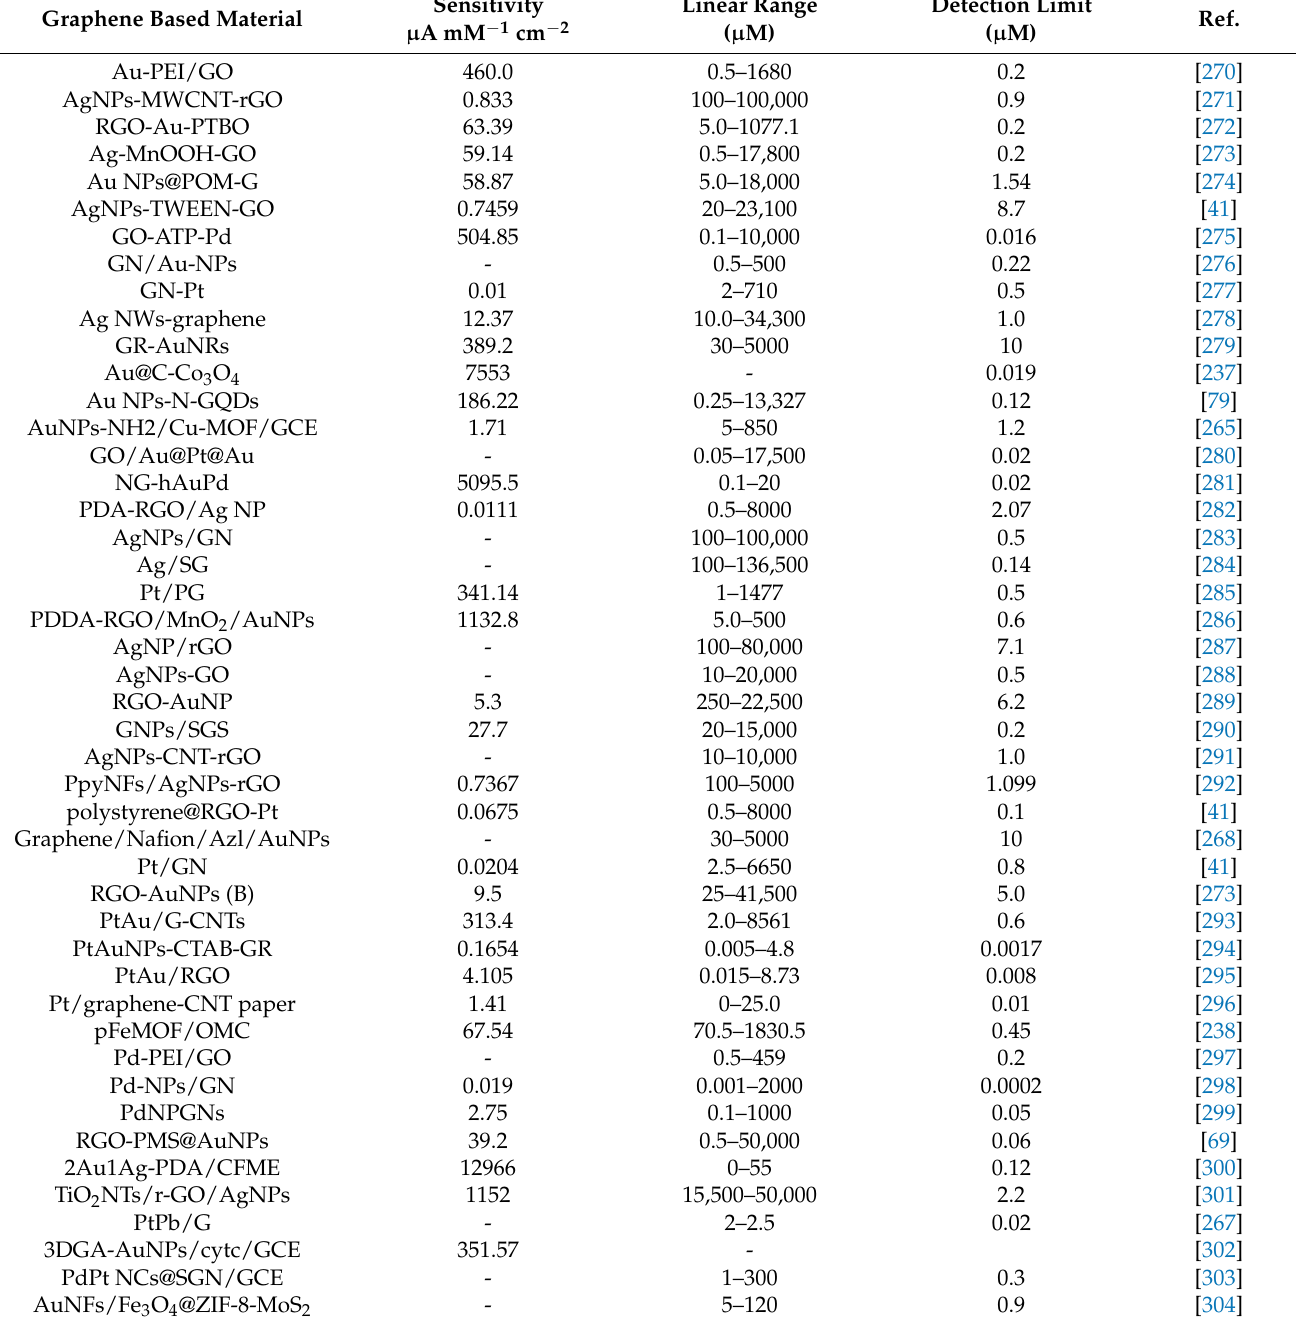
Table 4. Graphene supported noble metal nanoparticles for electrochemical detection of H 2 O 2 . Graphene Based